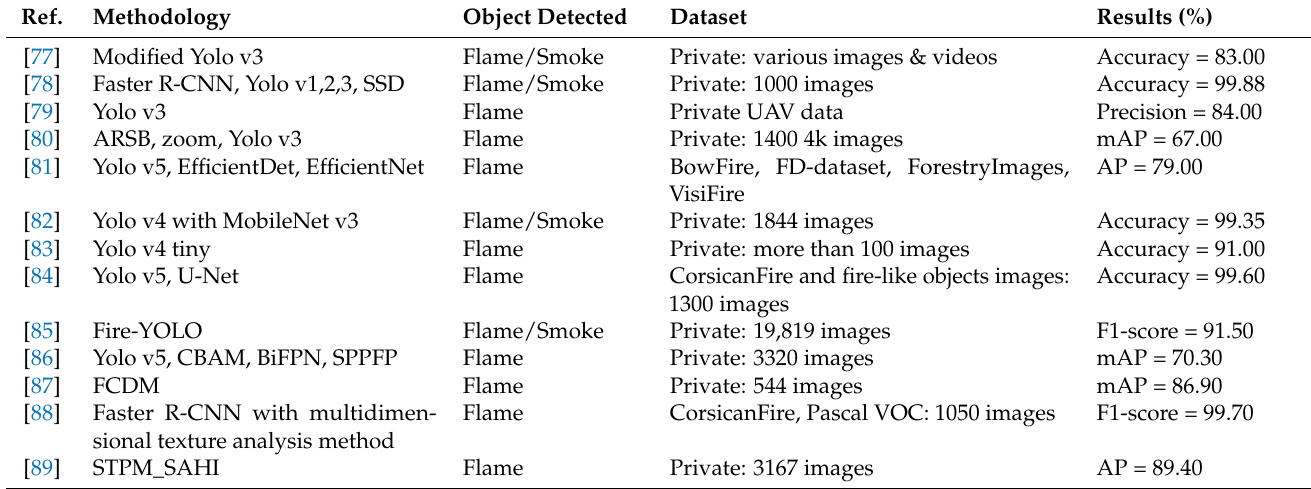
Table 2. Table 2. Deep learning based wildland fire detection